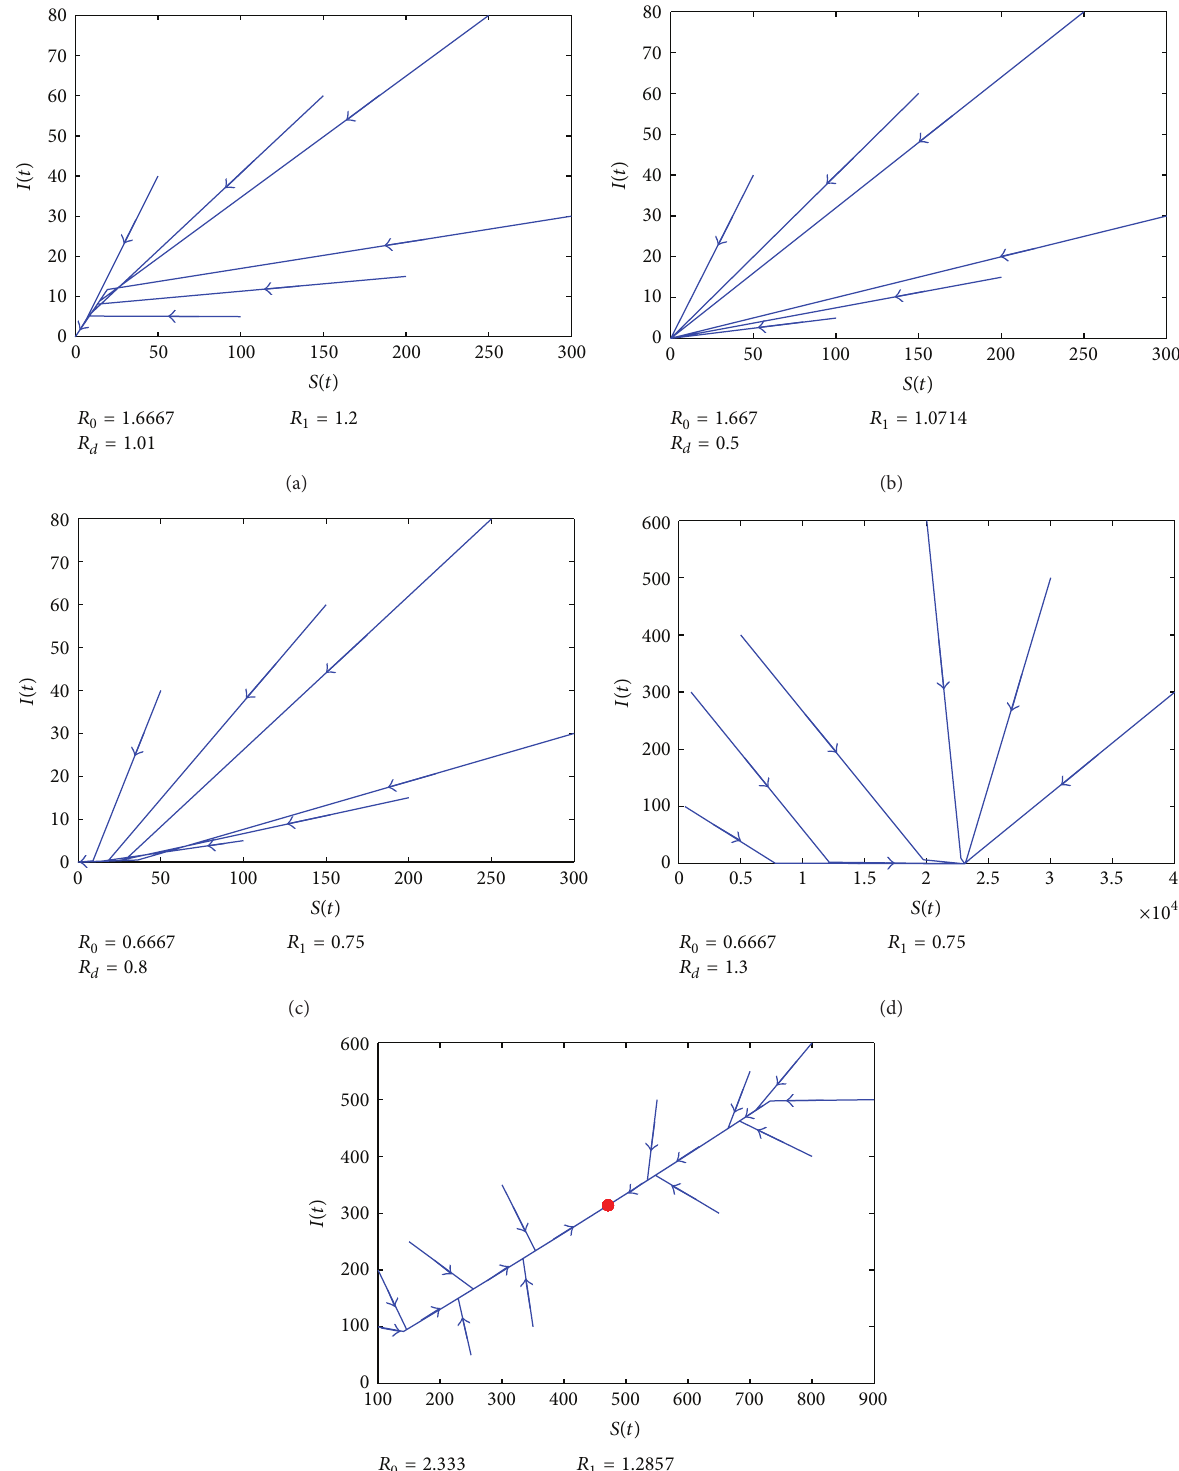
Figure 2: The phase curves of the system under different initial conditions. (a) In the region 𝑂 3 with 𝑟 = 0.101 and 𝛽 = 0.5 ; (b) in the region 𝑟 = 0.05 and 𝛽 = 0.35 ; (c) in the region 𝑂 𝑂 2 with 𝑟 = 0.13 and 𝛽 = 0.7 . The value of other parameters can be seen in Table 𝐸 ∗ with